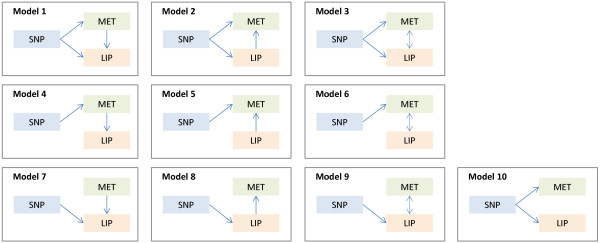
SEM models. The figure shows all 10 possible path models for a cross-associated set of a SNP, a metabolite or ratio, and a serum lipid, conditioned on the paths originating from the SNP [18]. Of these, only Models 4 to 10 were tested because Models 1 to 3 were overparameterized in our study (that is, they had zero degrees of freedom). Models 1 to 3 are also Markov equivalent and cannot be statistically distinguished.